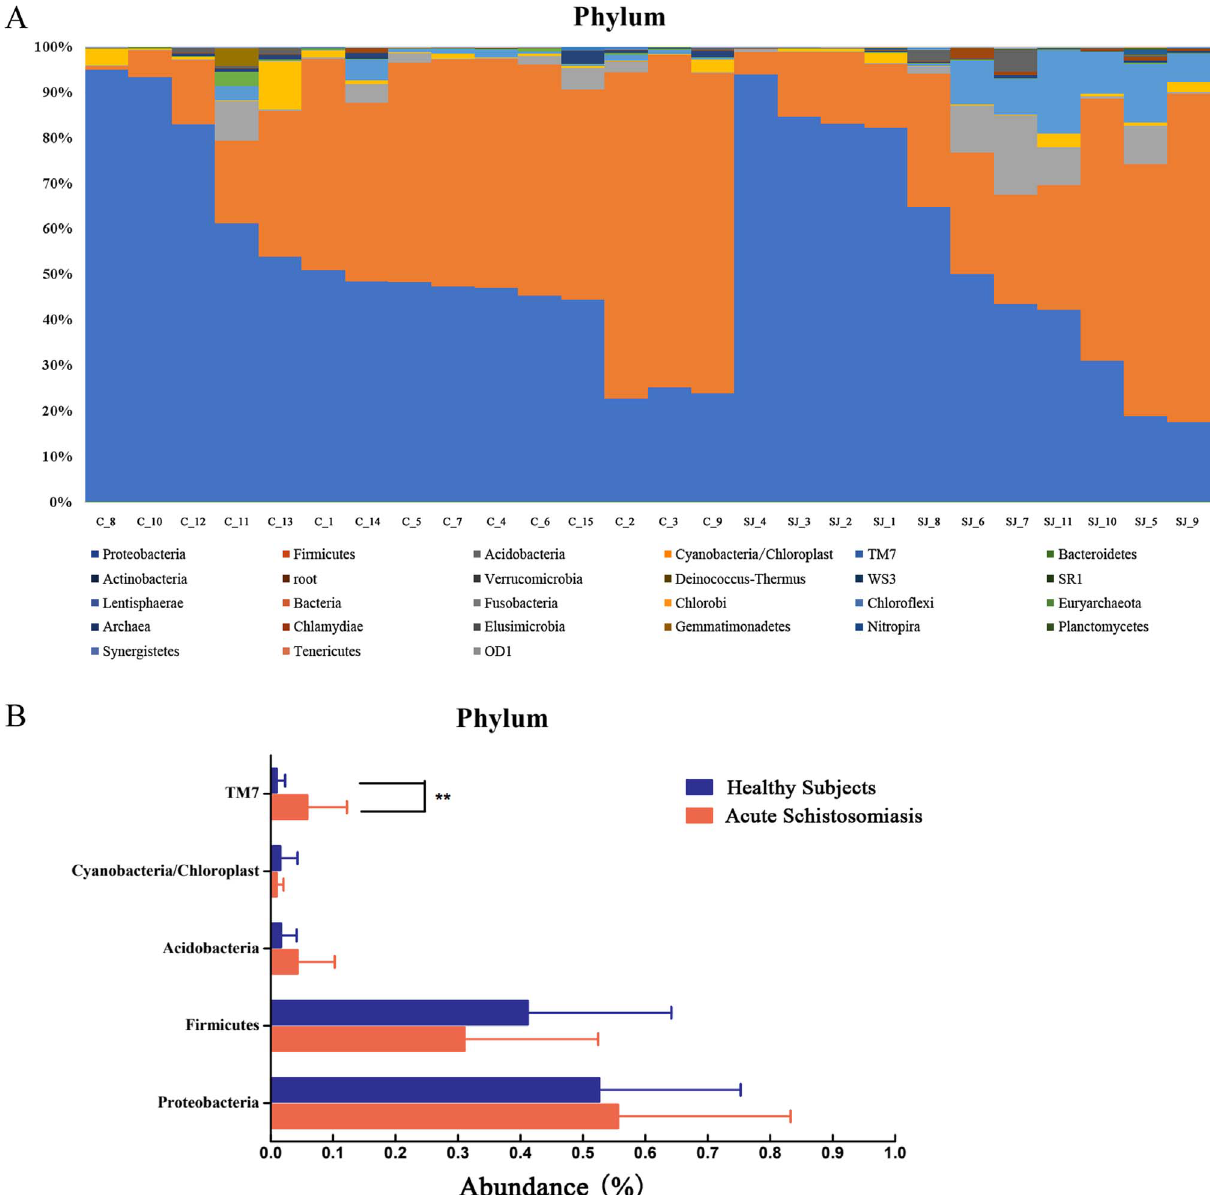
Figure 2. Differences in microbial community structure at the phylum level. (A) Proteobacteria and Firmicutes were the dominant phyla in both groups. (B) Signi fi cant difference in the relative abundance of TM7 between healthy controls and infected